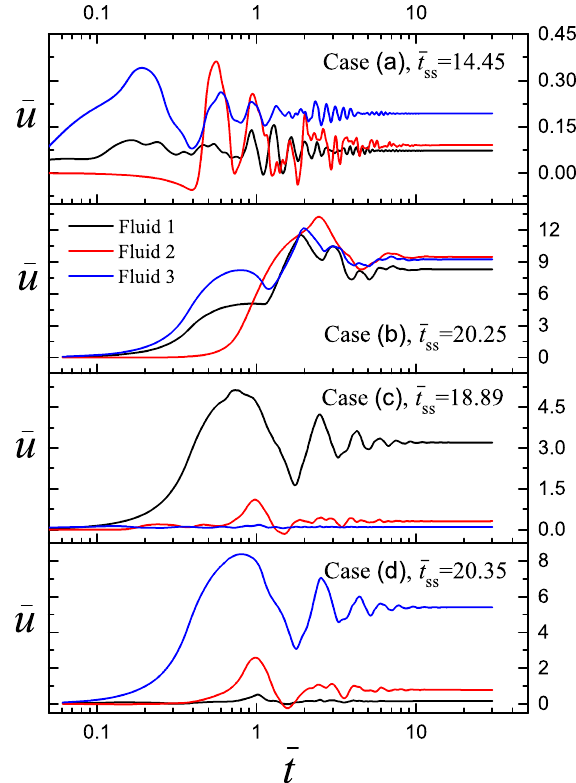
Figure 10. Velocity tracking of an electro-osmotic flow for Case ( a ) ¯ η 1,2,3 = ( 10,0.1,5.0 ) , Case ( b ) ¯ η 1,2,3 = ( 0.1,9.0,0.1 ) , Case ( c ) ¯ η 1,2,3 = ( 0.1,1.0,12 ) , and Case ( d ) ¯ η 1,2,3 = ( 12,1.2,0.1 ) , at the middle of each fluid layer. Figure 11 analyzes the value of the dimensionless internal radius of the microchannel a on the velocity tracking. This figure shows the velocity behavior at the middle of each fluid for a = 0.1, 0.4, 0.6 and 0.8. The above means, from the case with a widest annular microchannel cross-section ( a = 0.1) to the most narrow ( a = 0.8), respectively. As can be seen, narrow annular channels develop the first wave of the oscillatory regime more quickly than the wider channels. On the other hand, the first wave with the highest velocity is developed in the widest channel and reduces its magnitude as the channel becomes narrower. In addition, as the channel is thinner, the number and uniformity of the waves increase with the value of the dimensionless internal radius (compare case a = 0.1 with a = 0.8). With the above mentioned, it is clear that when the value of the dimensionless internal radius changes, it will affect the velocity magnitude, number and uniformity of the waves during the transient period. In another result, it can be concluded that the influence of a is small on the time in which the multilayer flow reaches the steady-state regime because the values of ¯ t ss are very similar in the presented